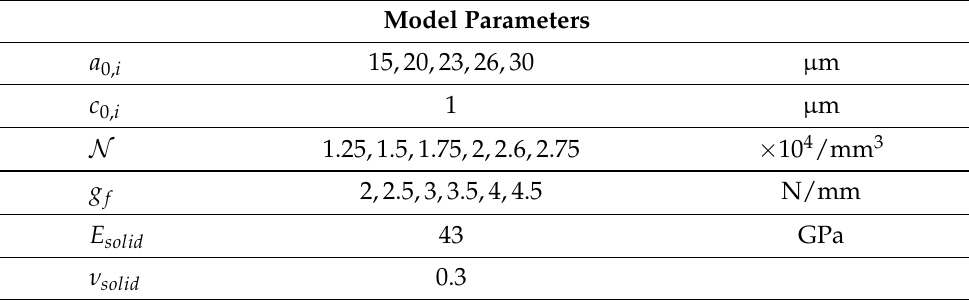
Table A1. Summary of parameters used for the parametric study.